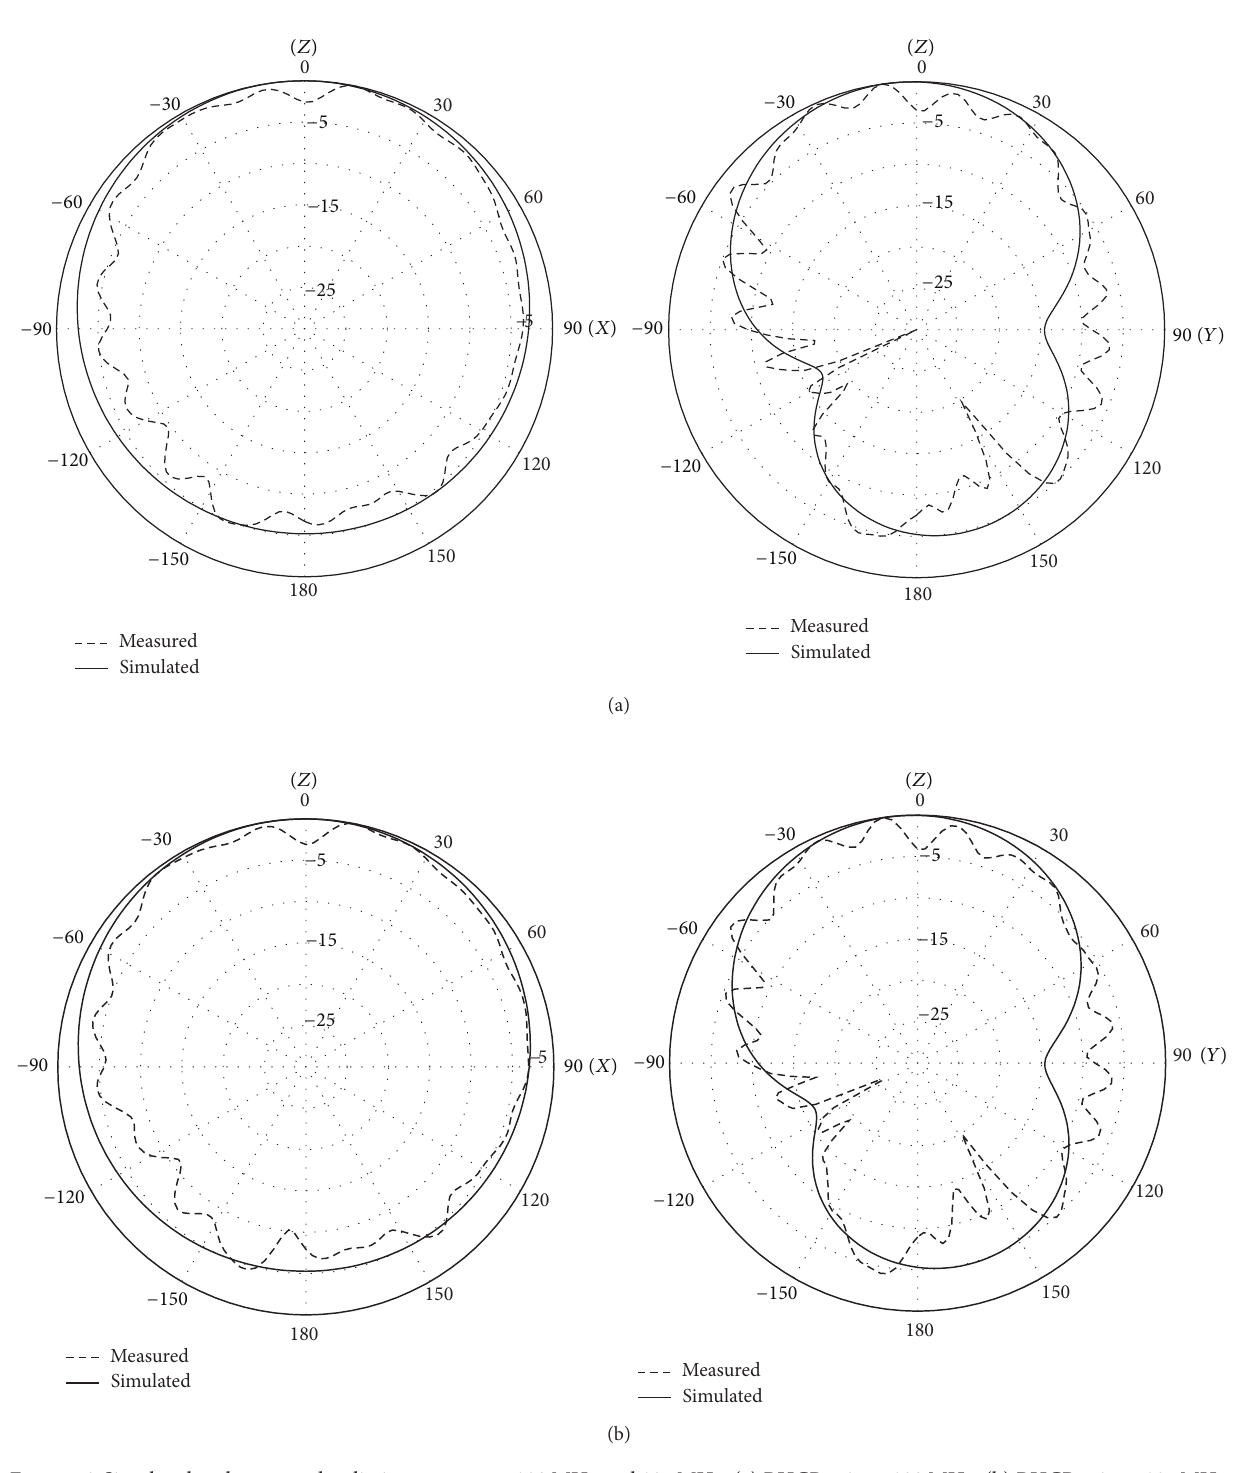
Figure 6: Simulated and measured radiation patterns at 920MHz and 925 MHz. (a) RHCP gain at 920 MHz. (b) RHCP gain at 925 MHz.